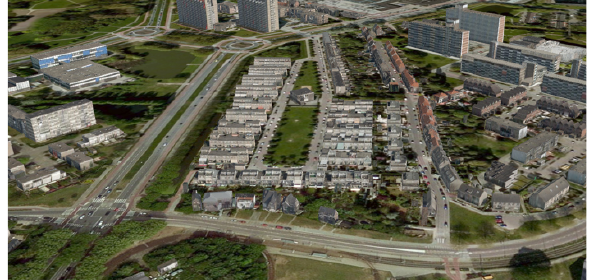
Figure 5 – 3D textured buildings in